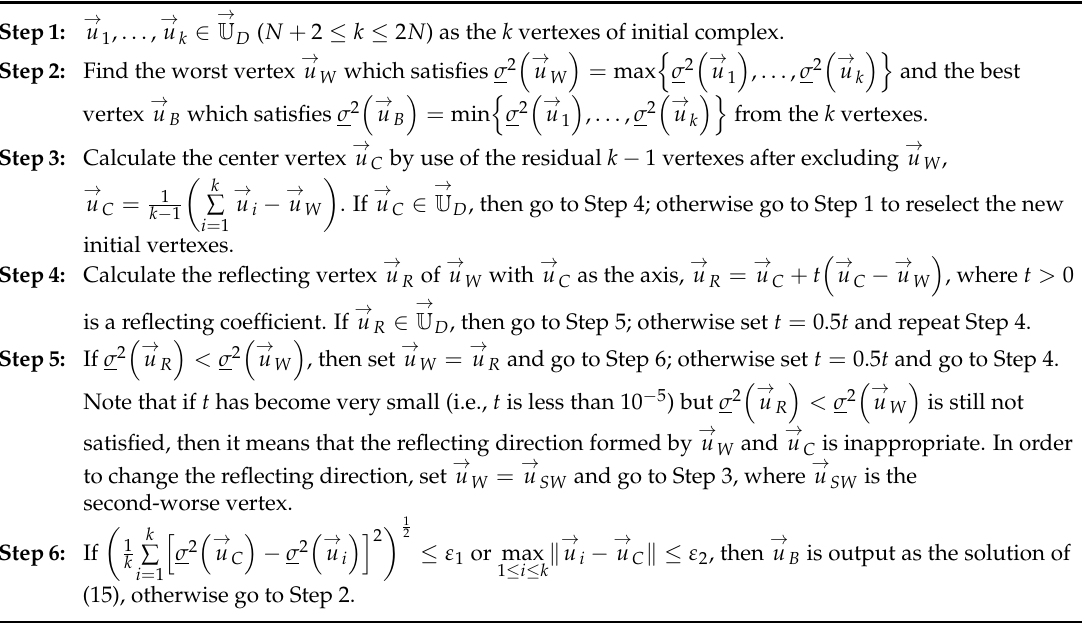
Table 3. Complex method for constrained multi-sensor